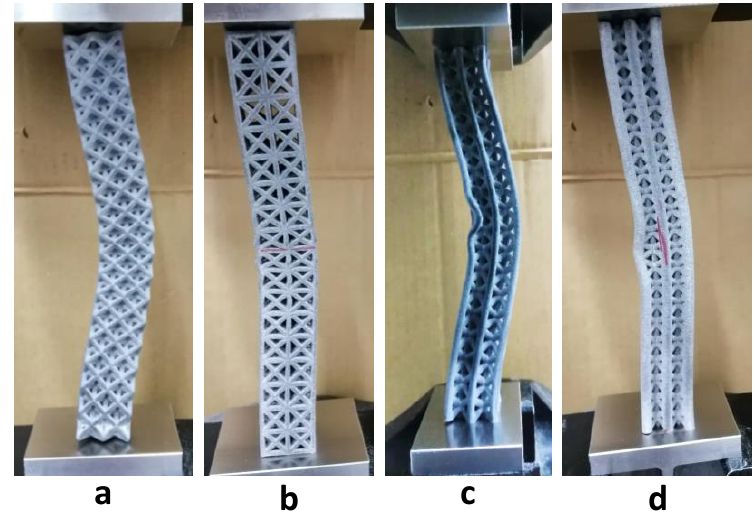
Figure 8. Buckling behavior of ( a ) octet truss and ( b ) inclined cubic structure ( c ) vertical inclined structure ( d ) vertical inclined (m1) structure.